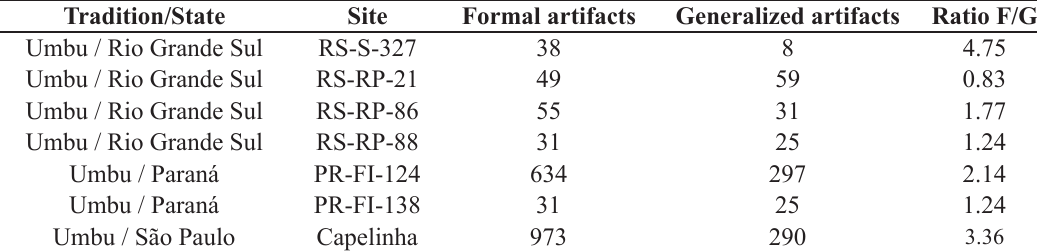
Ratios of Formal to Generalized (F/G) artifacts for some Umbu sites